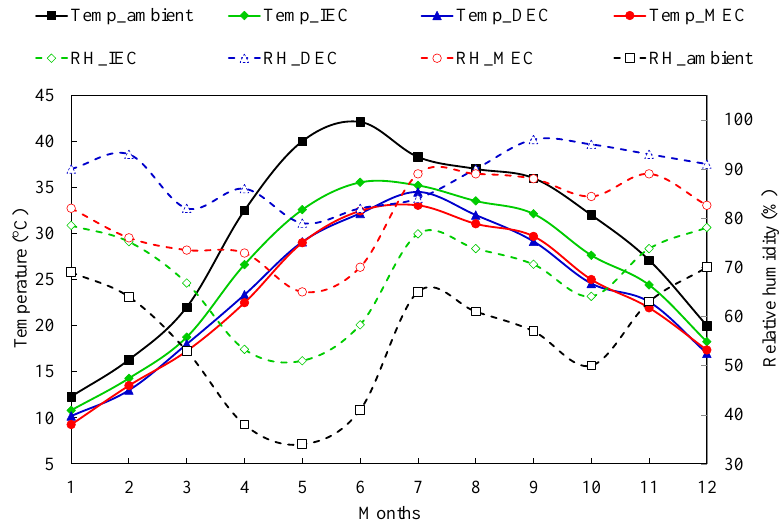
Figure 6. The annual profiles of temperature and relative humidity for ambient conditions of Multan and output conditions of the DEC, IEC, and MEC systems.